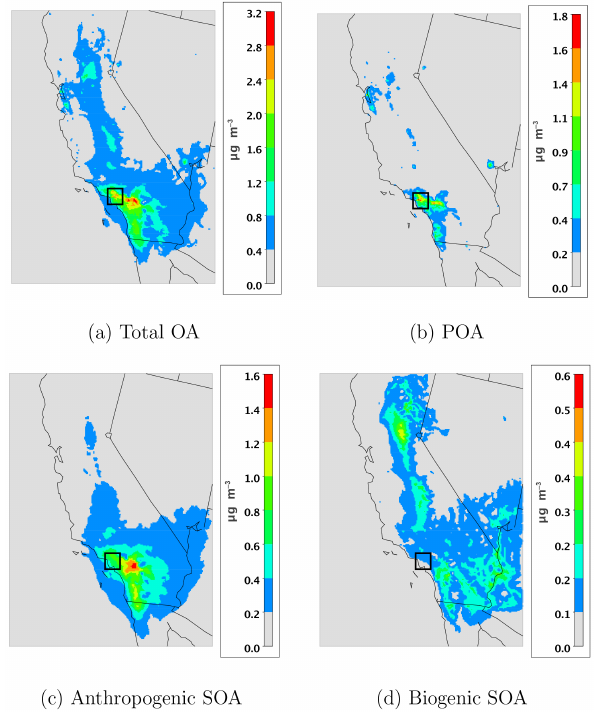
Figure 1. CMAQ-VBS modeling period average (15 May to 30 June 2010) concentrations of total OA (a) , primary organics (b) , anthropogenic SOA (c) , and biogenic SOA (d) . The black box in- dicates the approximate location of Downtown Los Angeles and Pasadena. Note each plot uses a unique